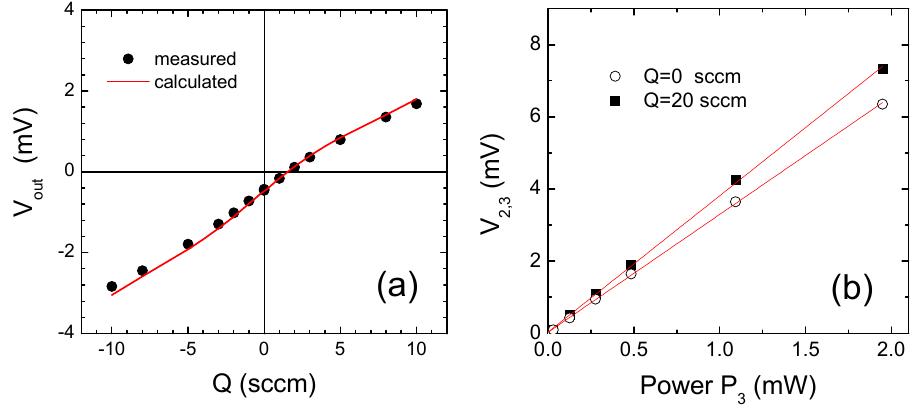
Figure 9. ( a ) Measured (symbols) and calculated (line) response of the triple heater sensor to a nitrogen flow with all the heaters powered with 1.25 mW; ( b ) Overheating of the 2nd thermopile with respect to H 3